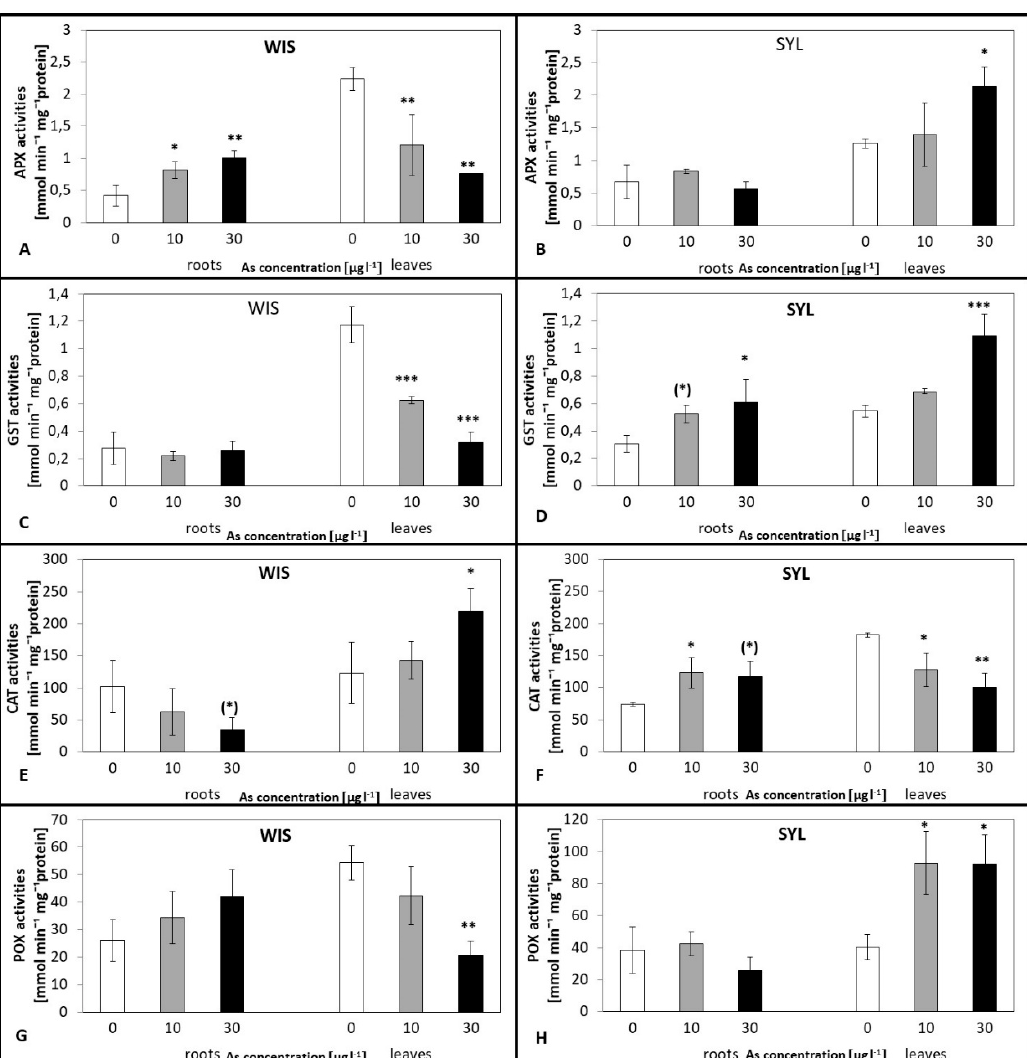
Figure 4. Effect of arsenic on the antioxidant enzymes activities in two contrasting tobacco genotypes ( A,C,E,G tolerant N.tabacum , cv.Wisconsin, B,D,F,H sensitive N. sylvestris ). 0, 10, and 30 µg l -1 arsenate treatments. APX—ascorbate peroxidase ( A,B ), GST—glutathione-S-transferase ( C,D ),